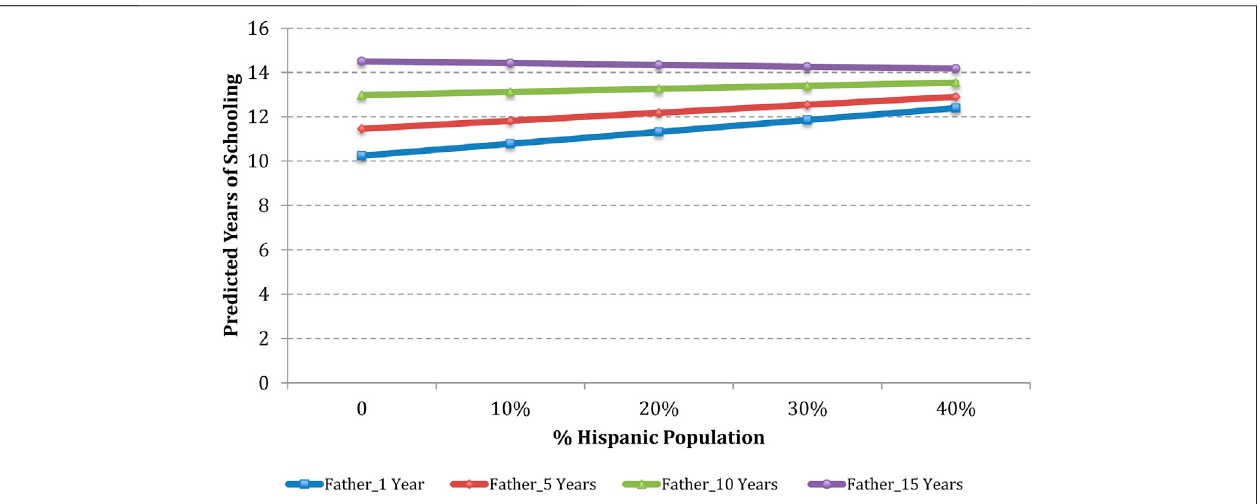
FIGURE1| Predictedyearsofschoolingof3+generationHispanicmenasafunctionoftheleveloffather ’ sschoolingandpercentageoftheHispanicpopulationin the county.